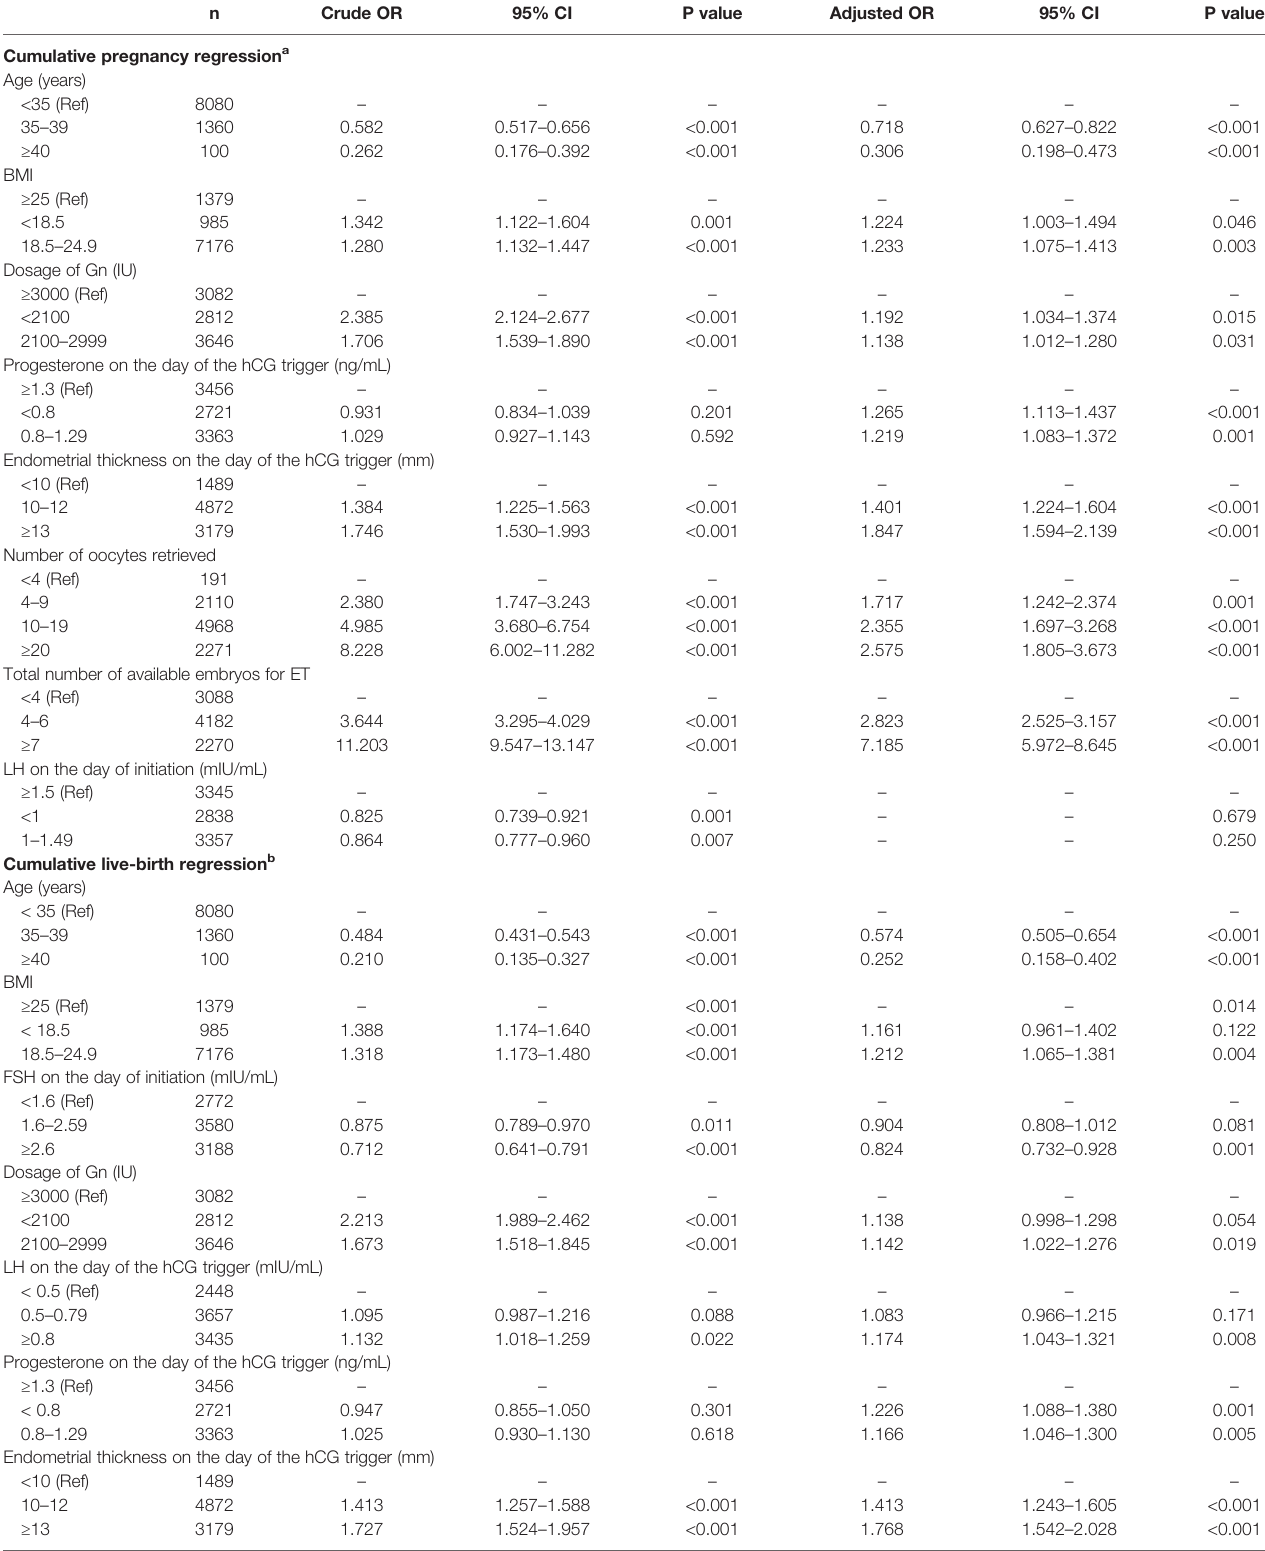
TABLE 5 | Univariate and multivariate analyses of clinical pregnancies and live births in entire ovarian